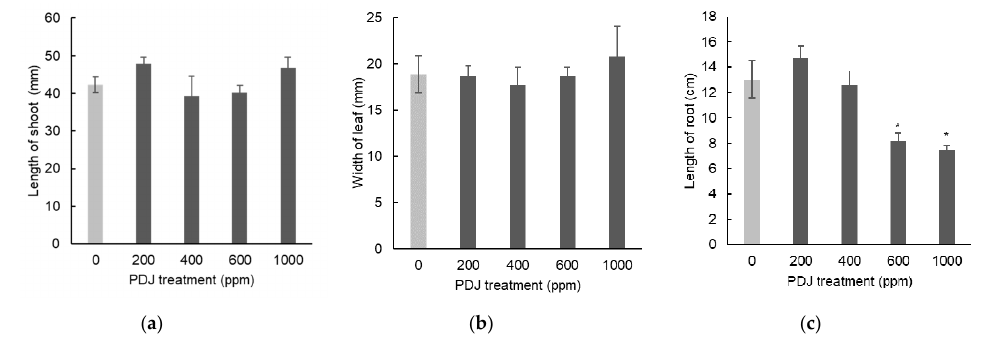
Figure 1. Shoot length ( a ), leaf width ( b ), and root length ( c ) of komatsuna seedlings treated with PDJ applied drip-wise at various concentrations. Komatsuna seeds were germinated and grown in soil, and PDJ was applied to seedlings at 1 week before harvest. Shoot length and leaf width values are the average difference between characteristics measured before and after treatment ( n = 4). Root length is average value ( n = 4) measured on the final day of pot culture (day 21). Error bars indicate standard error (SE). Asterisks (*) indicate statistically significant difference in comparison to the control using t-test at p < 0.05.